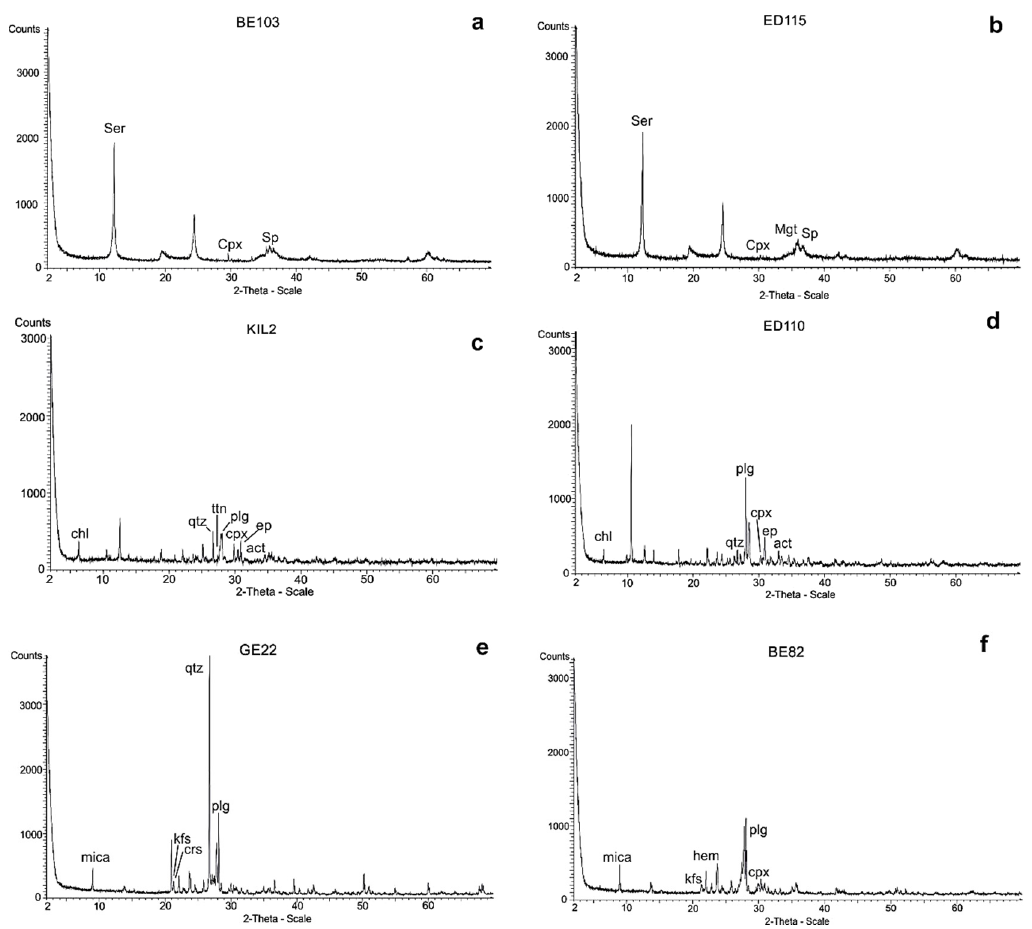
Figure 2. X-ray diffraction patterns of representative aggregate rocks: ( a ) Lherzolite (sample BE.103); ( b ) Harzburgite (sample ED.115); ( c ) Diabase (sample KIL.2); ( d ) Diabase (sample ED.110); ( e ) Dacite (sample GE.22); ( f ) Andesite (sample BE.82); Ser: serpentine, Cpx: clinopyroxene, Sp: spinel, Mgt: